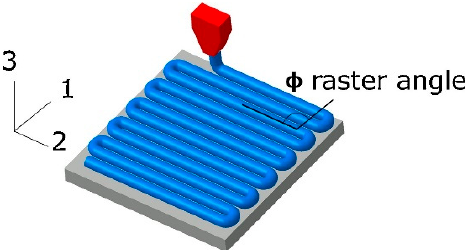
Figure 4. Example of meso-structure of 3D-printed parts with raster angle. Reprinted from [22], © 2018, with permission from Elsevier.